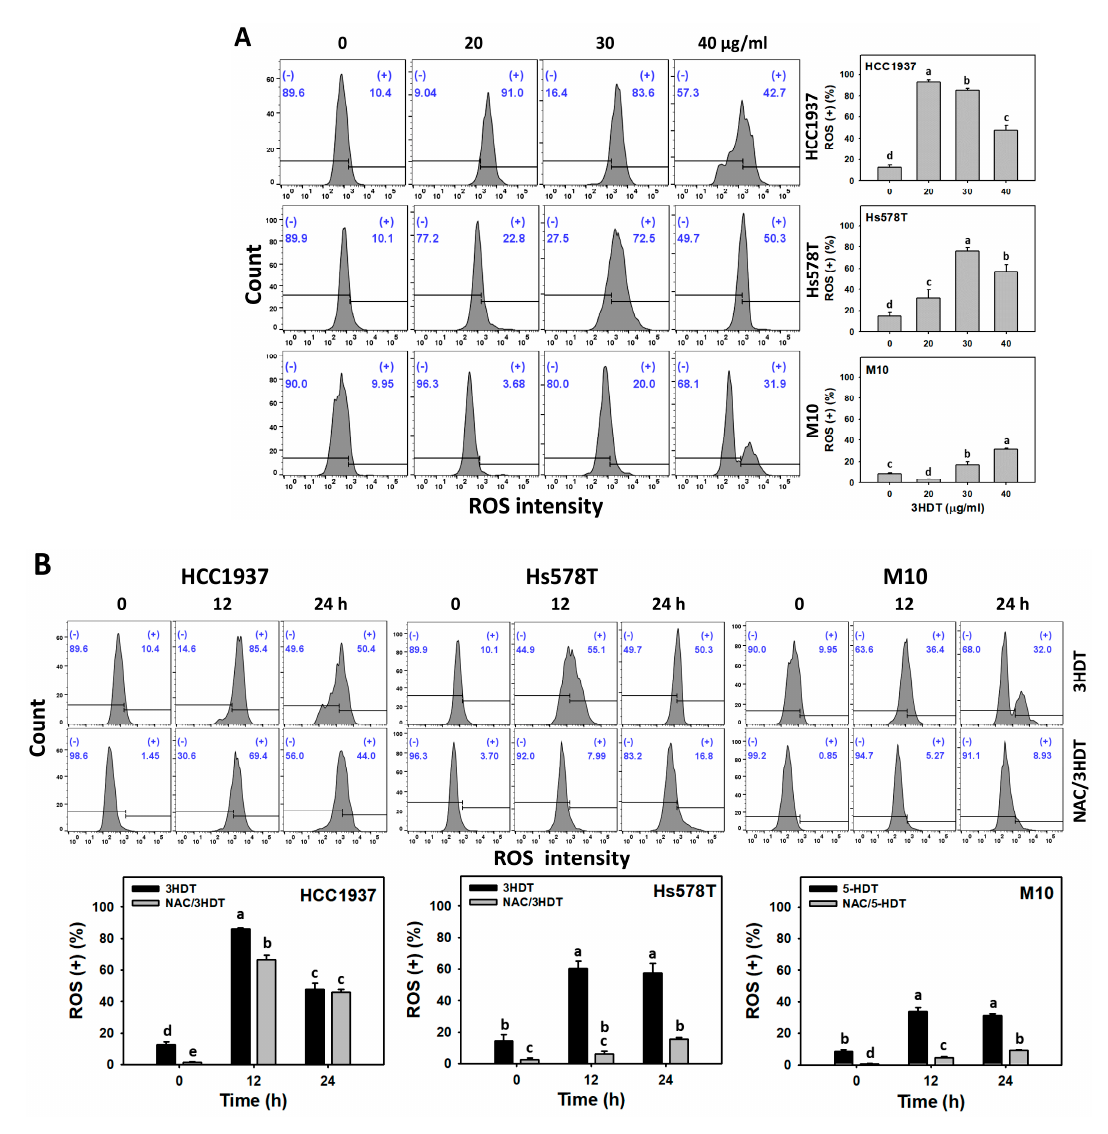
Figure 5. ROS status of 3HDT treatment. ( A ) ROS flow cytometry assay of 3HDT for 24 h. ( B ) ROS flow cytometry assay of NAC/3HDT. 3HDT and NAC/3HDT indicate 12 or 24 h 3HDT treatment (40 μ g/mL) without and with NAC pretreatment, respectively. (+) is marked as ROS (+), which indicates the proportion with high ROS level, while ( − ) indicates the proportion with low ROS level. Data: mean ± SD ( n = 3). Treatments differ significantly for multiple comparisons when the letters are not overlapping ( p < 0.05).